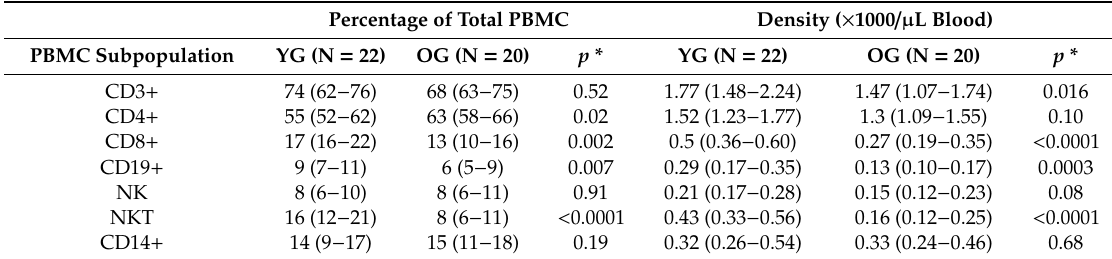
Table 2. PBMC composition in young and older women with